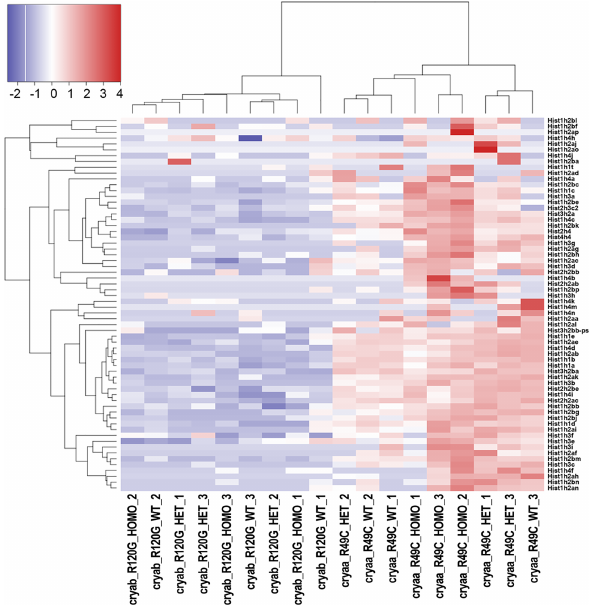
Fig 3. The heat map for change in histone genes in Cryaa -R49Cand Cryab -R120G knock-in mutant lenses as displayed by the R package heatmap3 [31]. In order to illustrate relativelog 2 fold-changes across samples,the values displayedper gene represent log 2 transformed counts-per-million with a prior count of 2, which were then rescaled to a mean of 0 with a standarddeviationof 1. The genes and samples were then re-organized by hierarchical clustering to illustrate the similarity of expressionchangeswithin and across genotypes. In one of the WT samples, the analysisof histonegene expressionappearedmore like that of the Cryaa -R49C-het sample, indicatingthat variability in the expressionof the histonegenescan occur even within the same genotype. This outlier was not the result of a sample mix-up, becausethe non-histone genesexhibitedthe same fold change and direction of change as the three